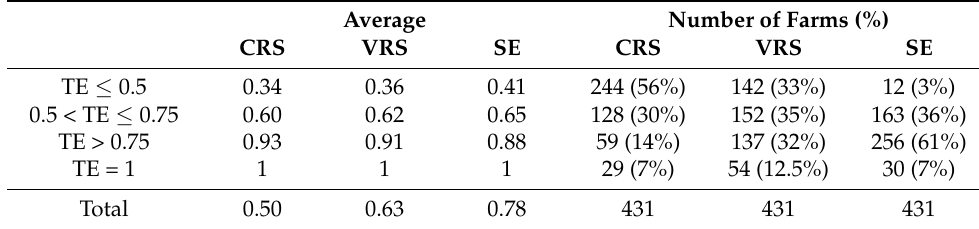
Table 5. Distribution of efficiency